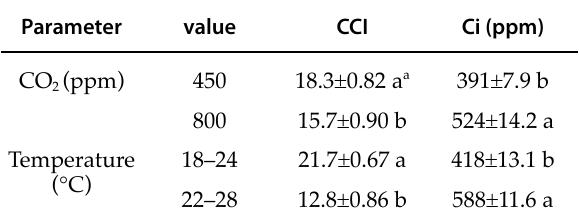
Table 4. Mean chlorophyll content indices (CCI) and in- tercellular carbon dioxide (Ci) in 2nd leaves of zucchini plants grown in different temperature and CO 2 regimes considering temperature or CO 2 . Data are shown as means ± SE (n ≥5). Average results of five